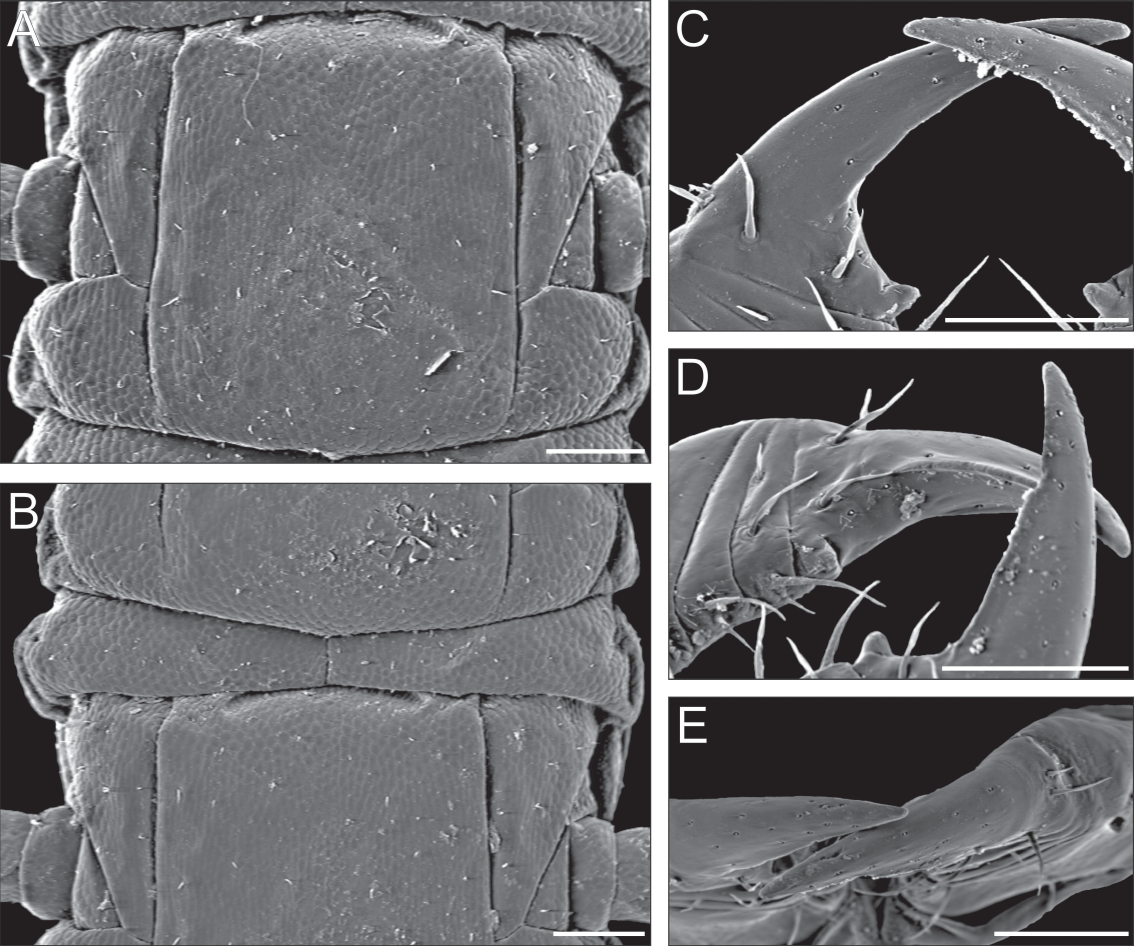
Fig. 3. Endogeophilus ichnusae gen. et sp. nov., paratype A, ♂. A . Leg-bearing segment 20, ventral view. B . Posterior part of leg-bearing segment 21 and anterior part of segment 22, ventral view. C . Right forcipular tarsungulum, ventral view. D . Right tarsungulum, ventro-mesal view. E . Right tarsungulum, frontal view. SEM micrographs. Scale bars = 50